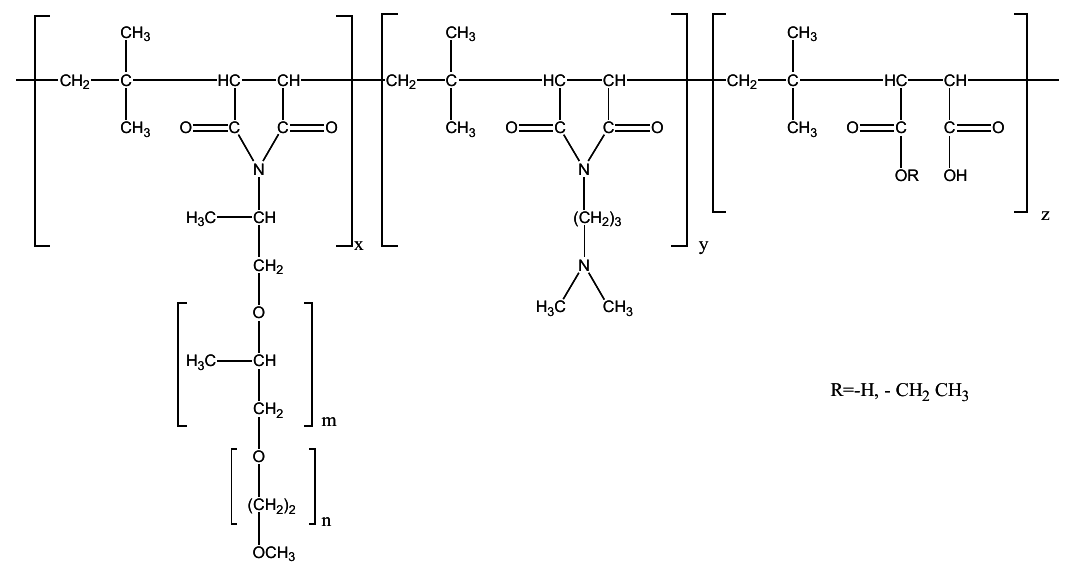
Figure 1. Chemical structure of polyimide-1.